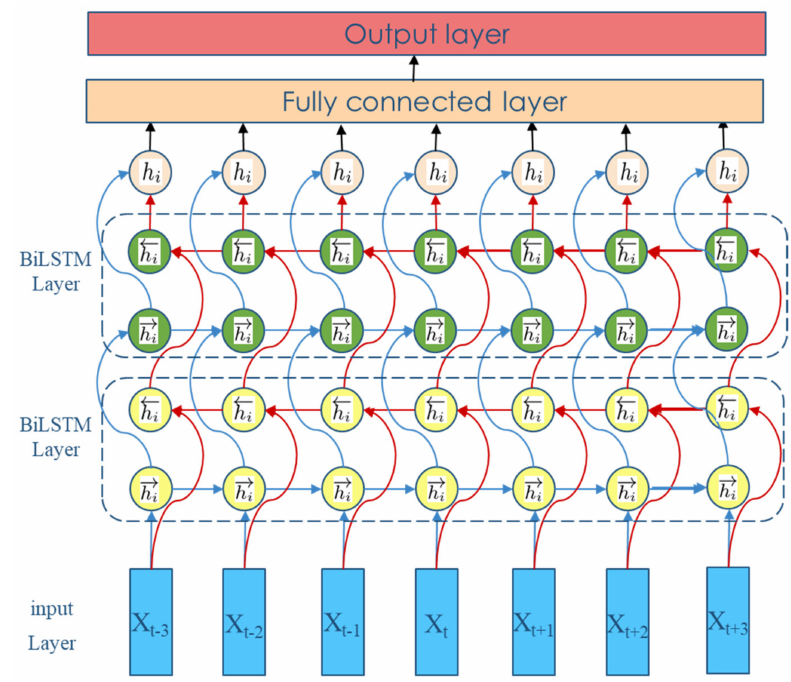
Figure 2. Schematic diagram of Bi-LSTM network